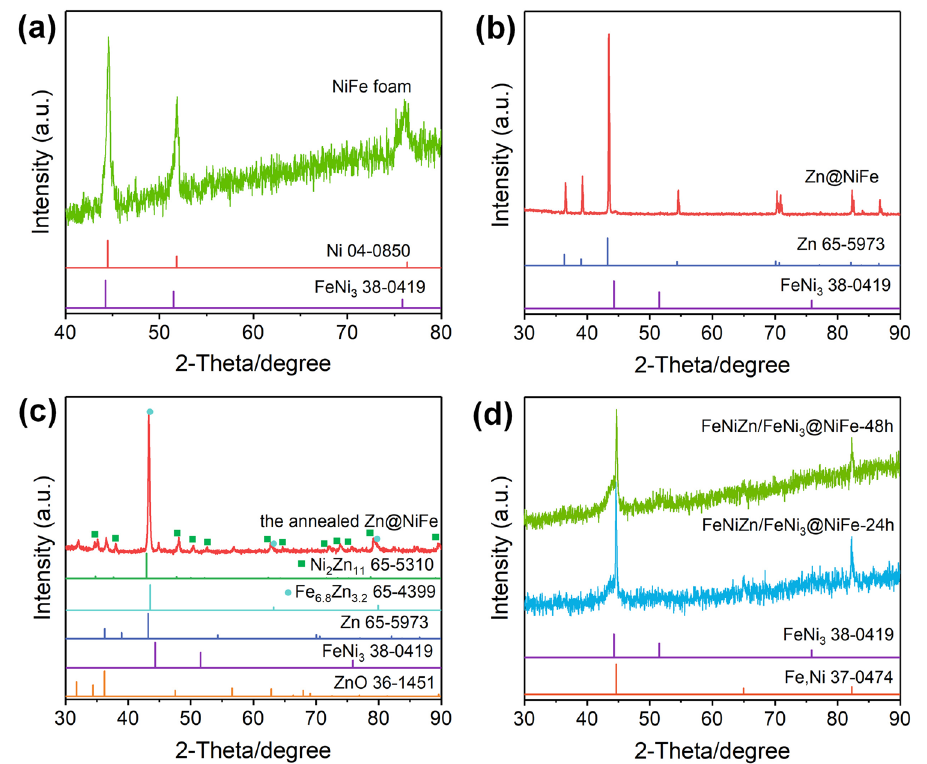
Fig. 2 XRD patterns of a NiFe foam, b Zn@NiFe sample by electroplating Zn on NiFe foam, c the annealed Zn@NiFe sample, and d FeNiZn/ FeNi 3 @NiFe samples by dealloying in 2.0 M ammonia solution for 24 and 48